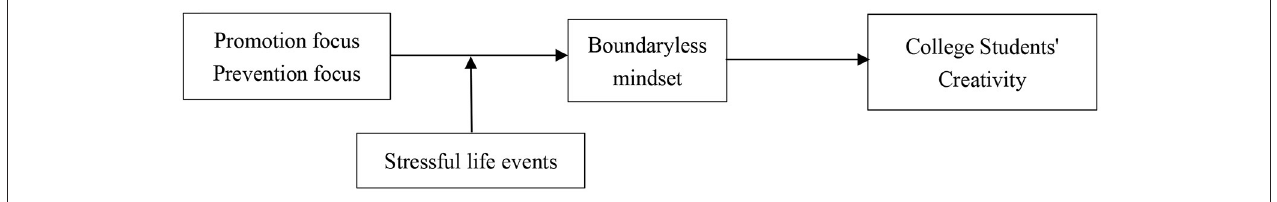
FIGURE 1 | The proposed moderated mediation